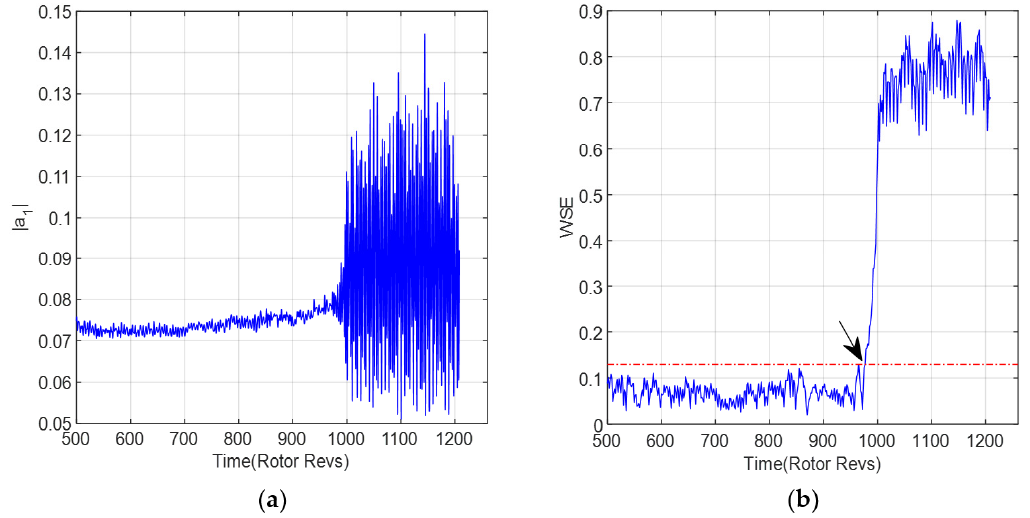
Figure 6. Wavelet singular spectral entropy of the spatial mode at 2500 rpm: ( a ) First-order space mode; ( b ) Wavelet singular spectral entropy.